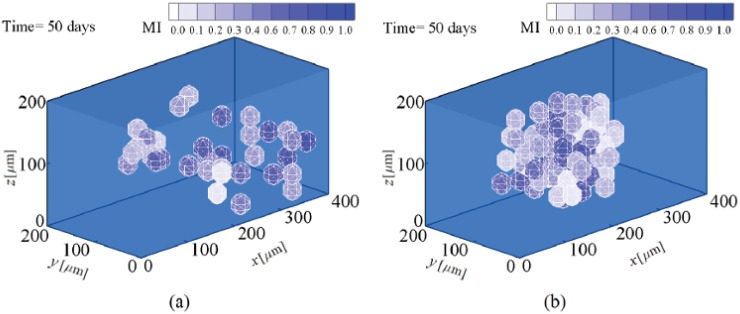
Osteoblast proliferation in hard substrates.a- 30 kPa and b- 45 kPa stiffness (see also S2 Video).